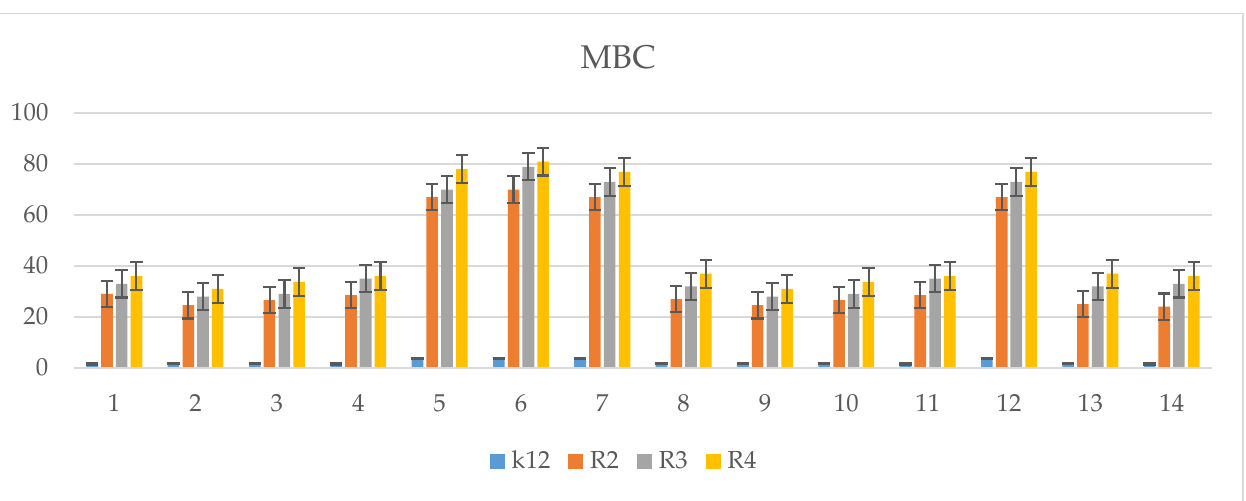
Figure 4. Minimum inhibitory concentration (MIC) of the β -phosphonate derivatives in model bacterial strains. The x -axis features compounds 1 – 14 used sequentially. The y -axis shows the MIC value in µg/mL − 1 . Investigated strains of E. coli K12 as control (blue), R2 strains (orange), R3 strain (grey), and R4 strain (yellow). The y -axis shows the MBC value in µg/mL −1 . The order in which the compounds were applied to the plate are shown in Supplementary Materials Figure S1.